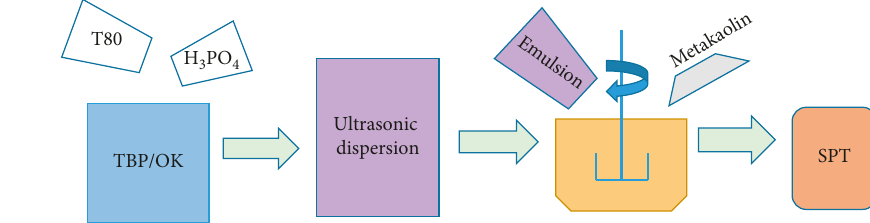
Figure 1: Preparation of the solidified SPT.